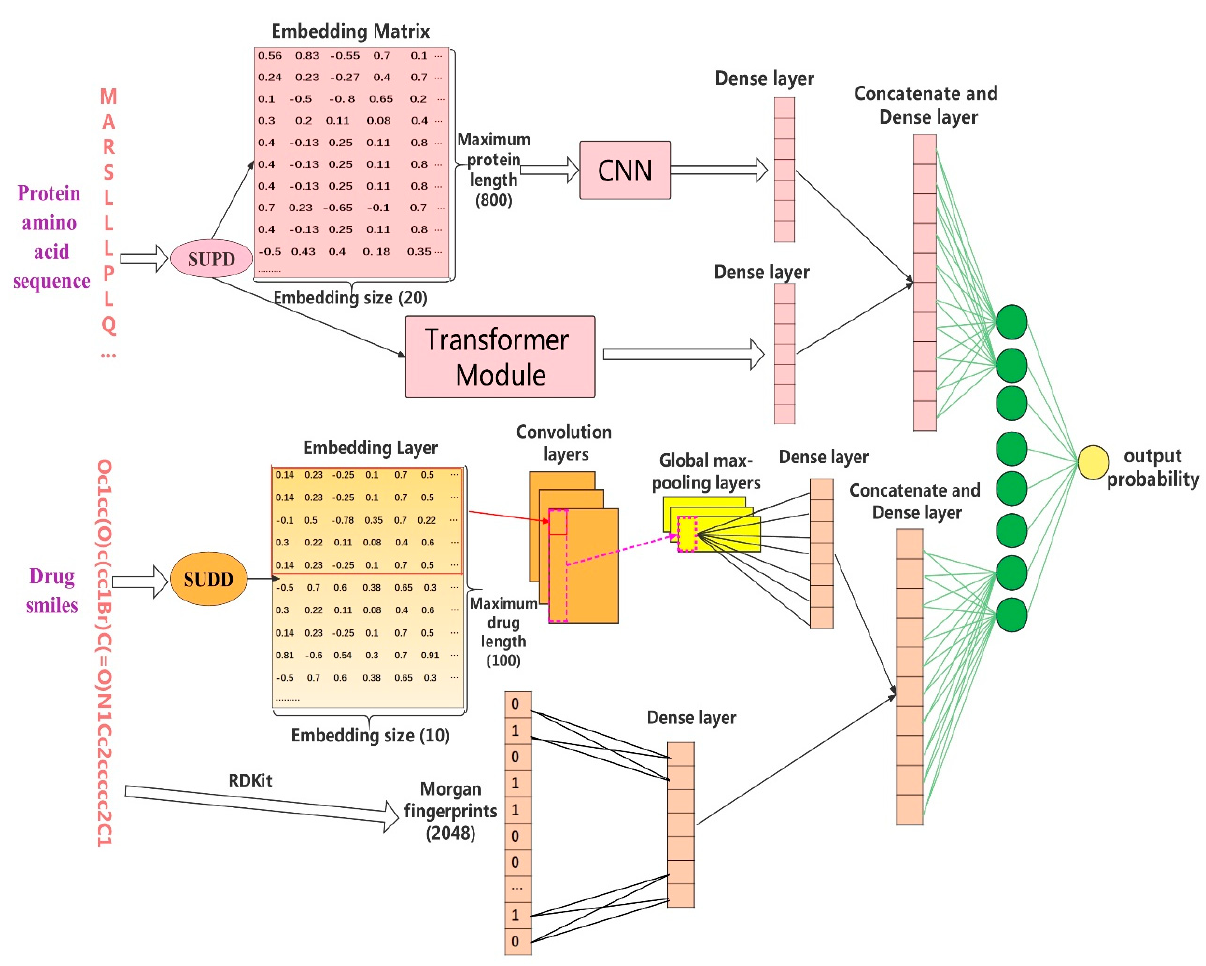
Figure 3. Overall architecture of